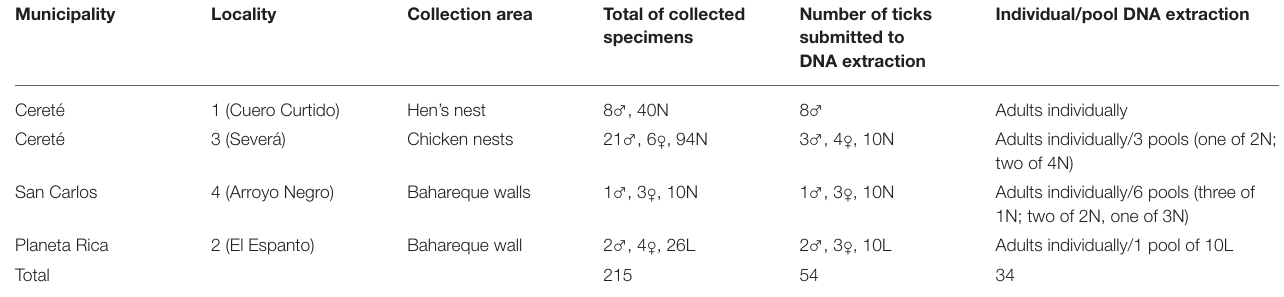
TABLE 1 | Ornithodoros spp. collected in rural dwellings from Córdoba department, Colombia. Municipality